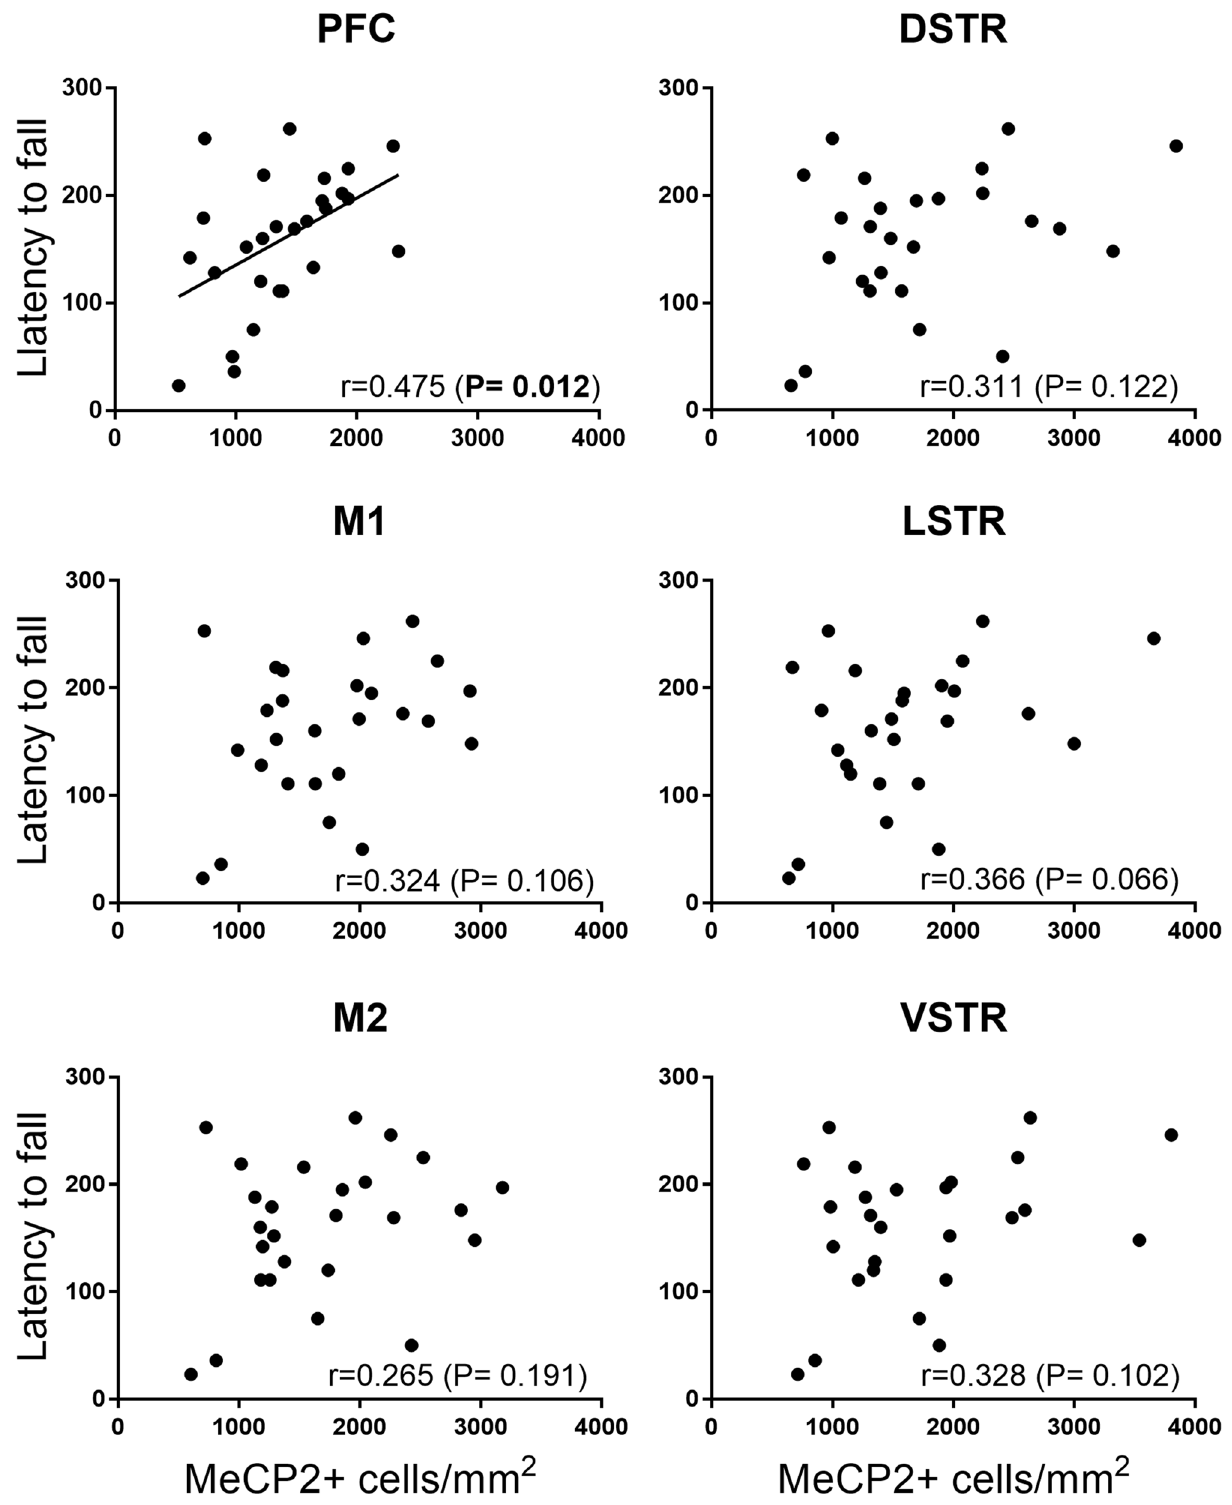
Figure 3. Correlation between the number of MeCP2 + cells in various brain regions of Mecp2 HET mice and the latency to fall from the rotarod (in seconds) assessed in the same mice. The correlation coefficient (Pearson r) associated probability and graph for each brain area were generated by the Prism software (version 7.02; https:// www. graph pad. com/ scien tific- softw are/ prism/). Significant correlations are highlighted in bold type. PFC prefrontal cortex, M1 motor cortex 1, M2 motor cortex 2, DSTR dorsal striatum, LSTR lateral striatum, VSTR ventral